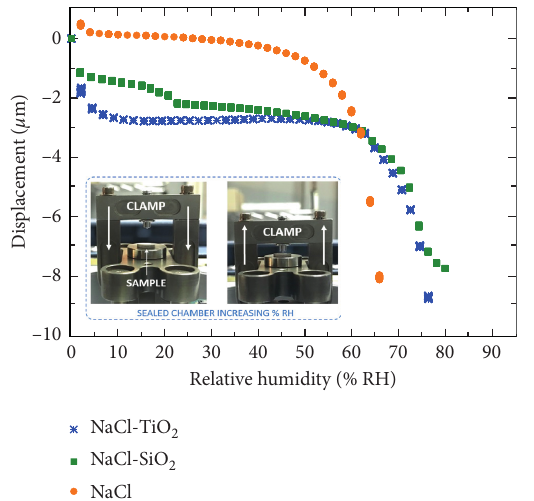
Figure 16: Humidity-controlled dynamic mechanical analysis of NaCl, NaCl-TiO 2 , and NaCl-SiO 2